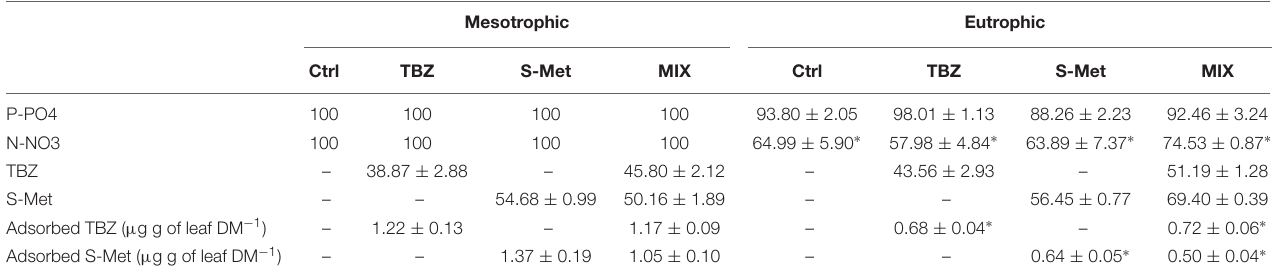
FIGURE 1 | Molar C:P (A) and N:P (B) ratios recorded at the end of the experiment in leaves exposed to fungicide (TBZ), herbicide (S-Met), both fungicide + herbicide (MIX) or non-exposed (Ctrl), in either mesotrophic (white fill) or eutrophic (gray fill) nutrient condition. Values are median + quartiles 1 and 3 ( n = 3). Differences between nutrient conditions are represented by an asterisk (Kruskal–Wallis, P < 0.05). TABLE 2 | Average percentage of nutrients and pesticides dissipation as well as adsorbed pesticides on leaves recorded at the end of the experiment in experimental stream channels exposed to fungicide (TBZ), herbicide (S-Met), both fungicide + herbicide (MIX) or non-exposed (Ctrl) in either mesotrophic or eutrophic nutrient condition.